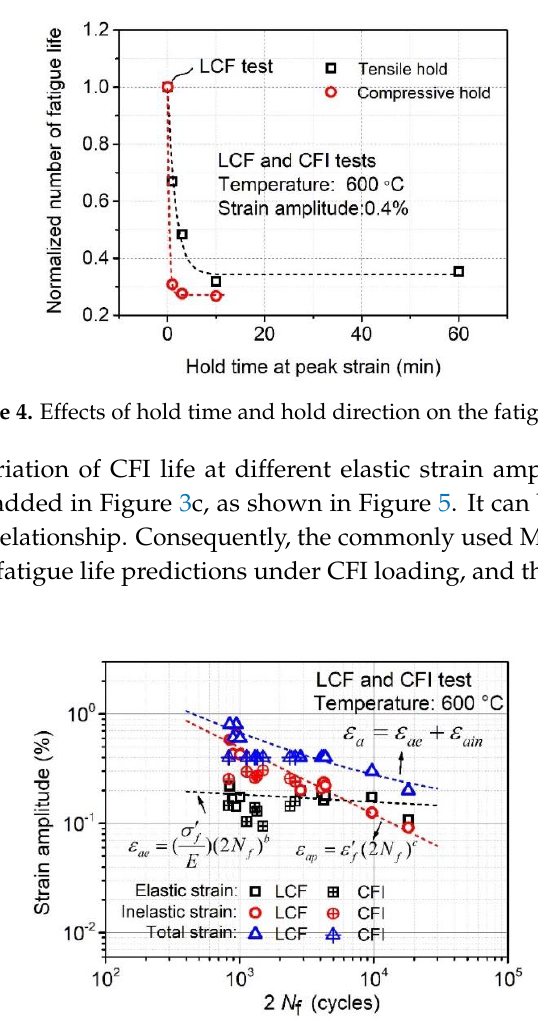
Figure 3. Strain amplitude versus cycle number of fatigue life at different temperatures: ( a ) 20 °C, ( b ) 550 °C, ( c ) 600 °C, ( d ) 650 °C.